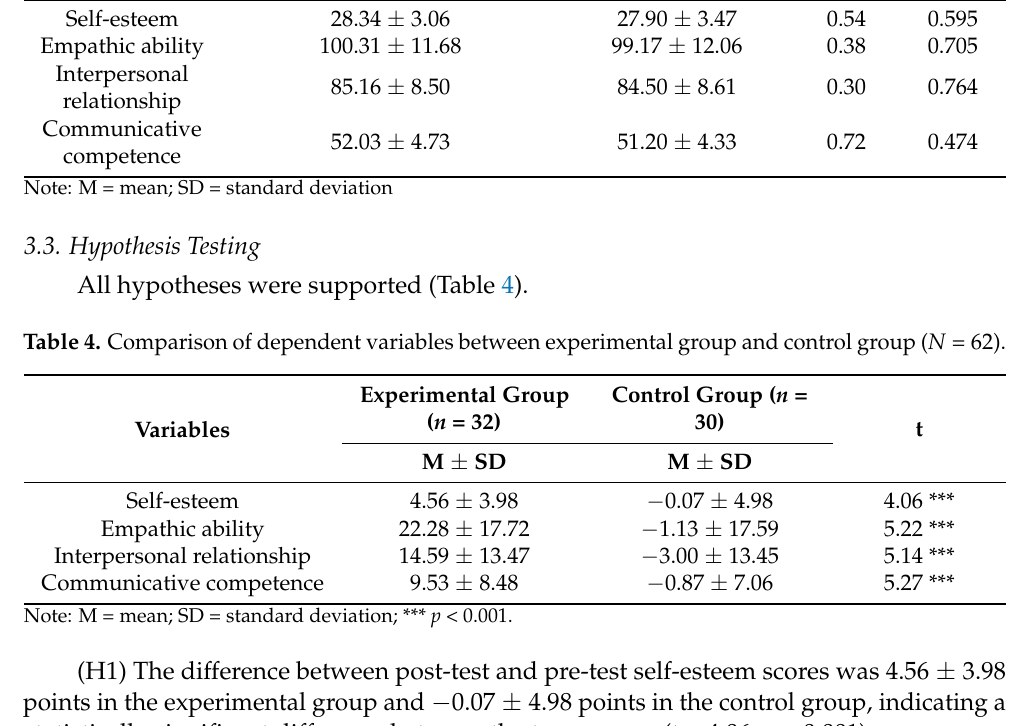
Characteristics